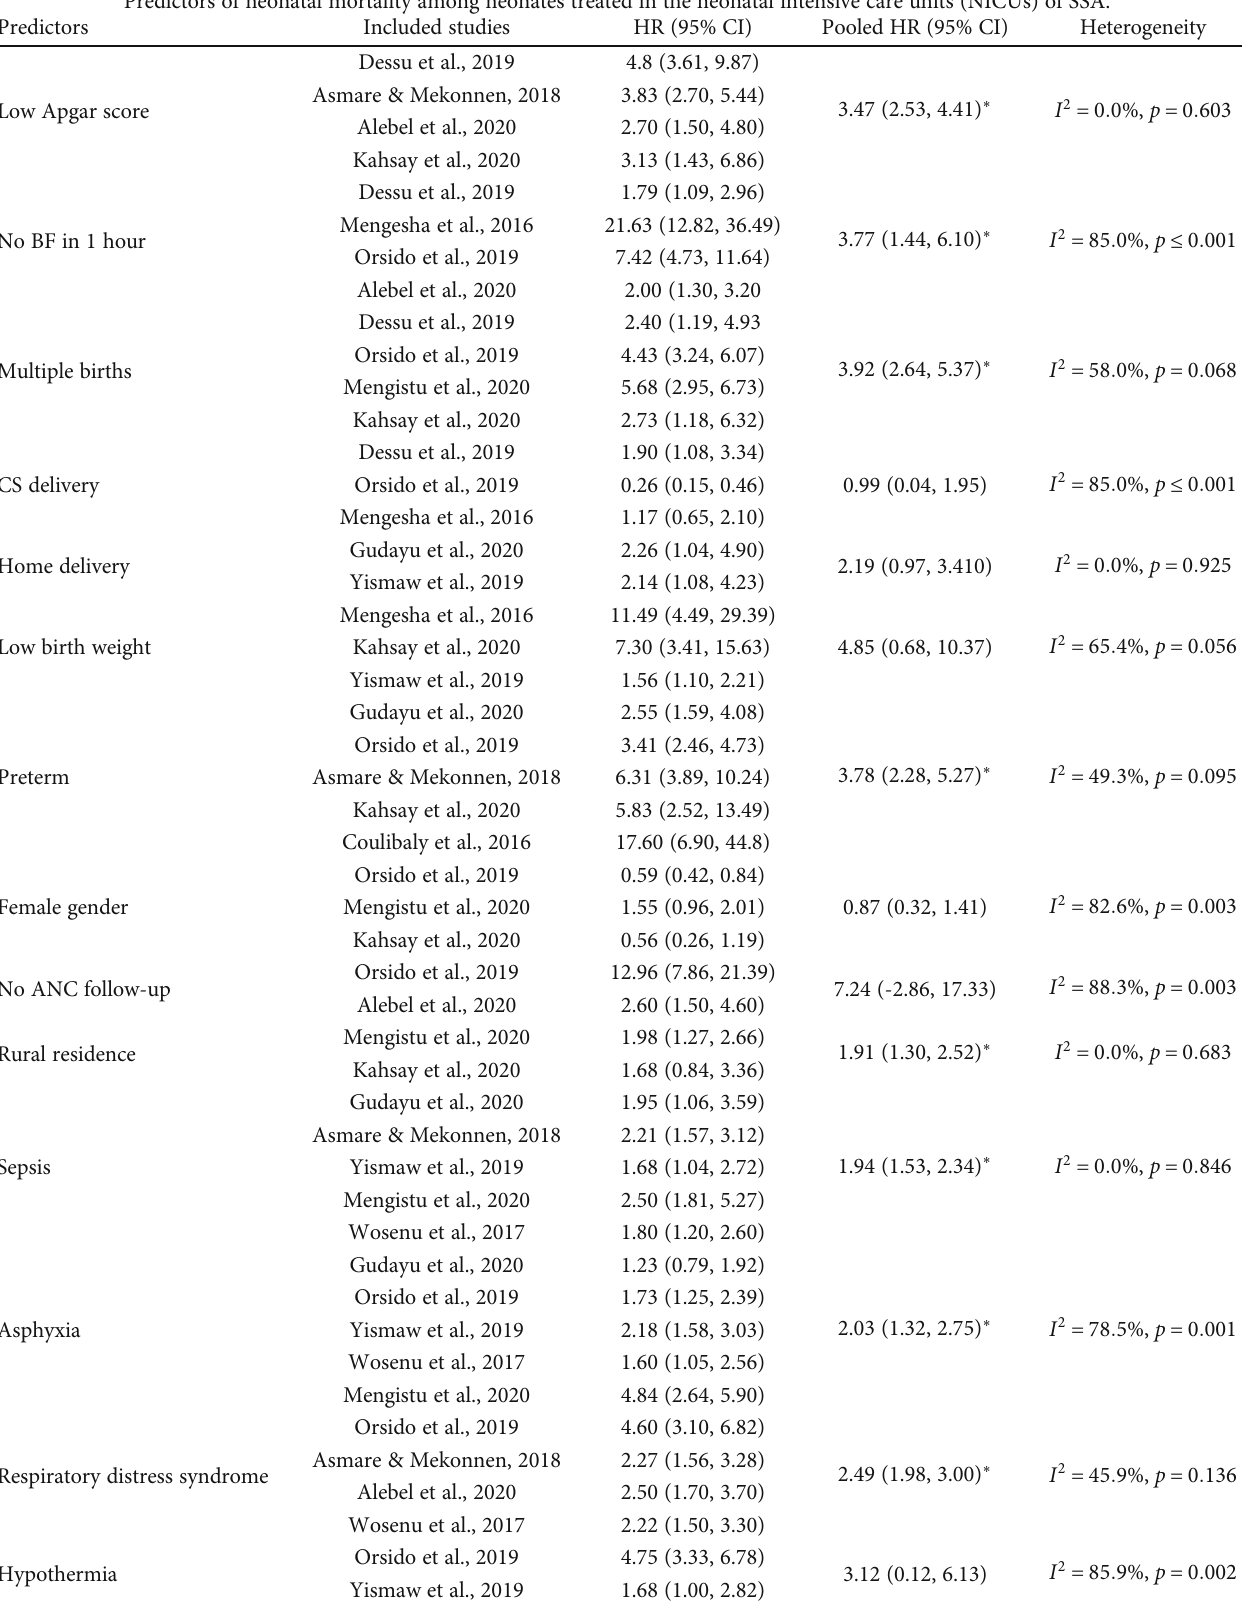
Table 2: Predictors of neonatal mortality in Sub-Saharan